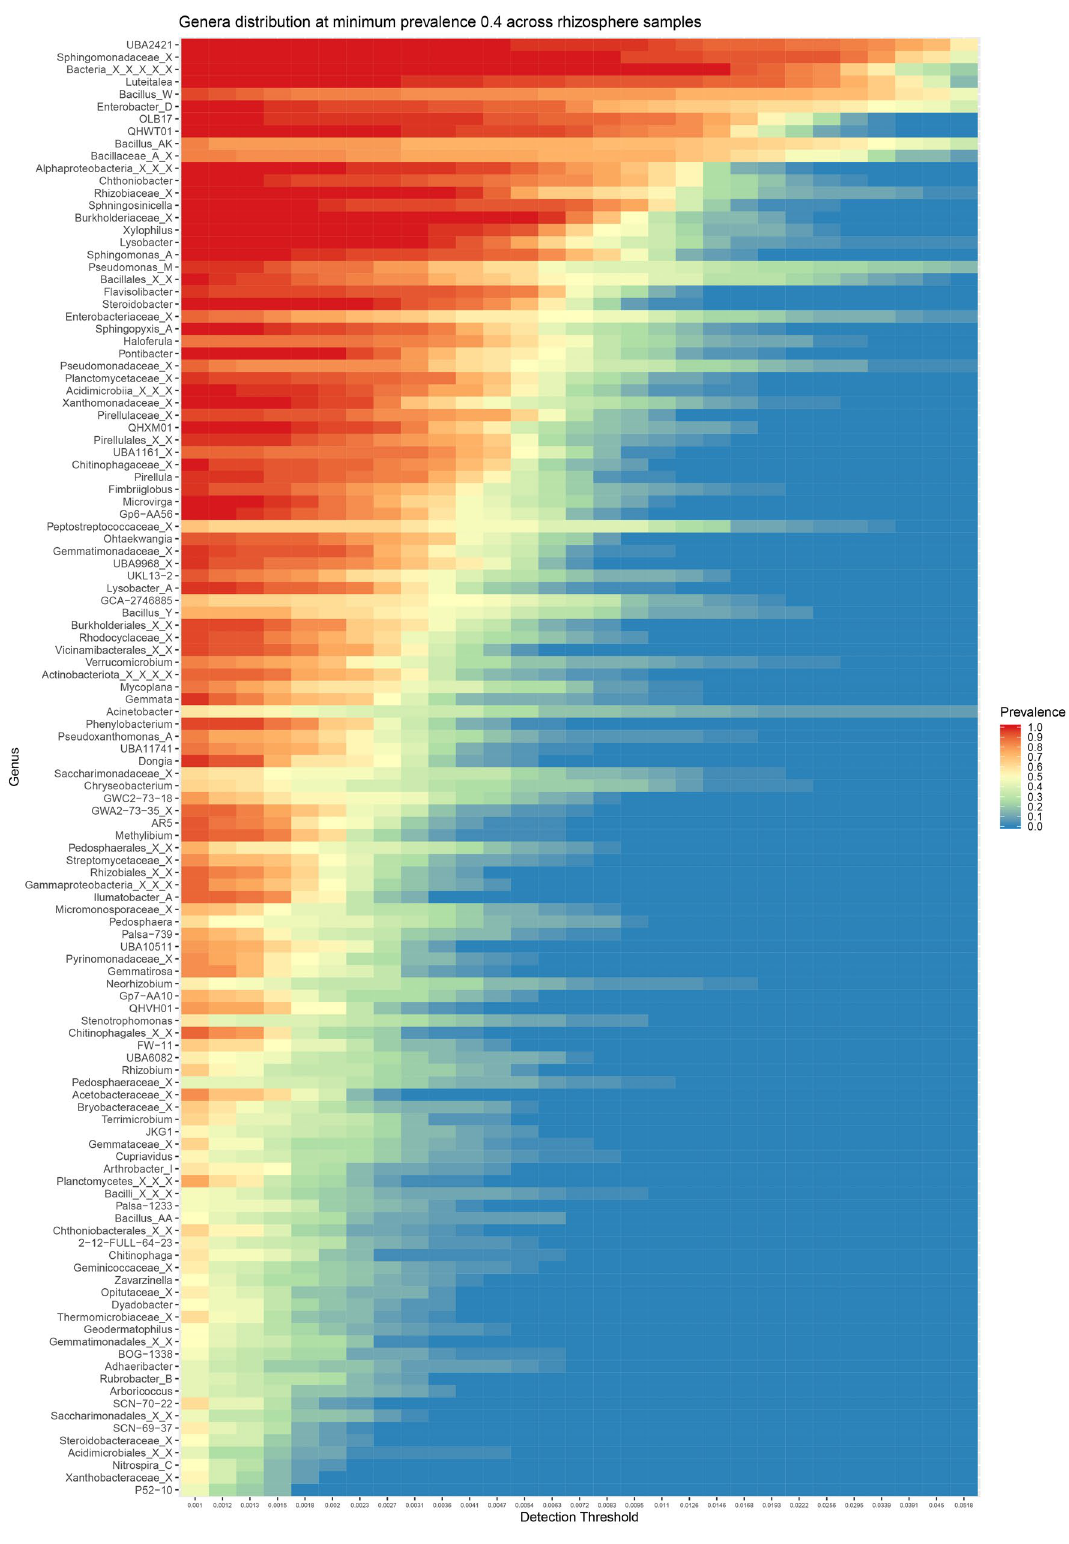
Figure 4. Plot representing core microbiome from rhizosphere samples. The plot compares prevalence of genus in samples across varying levels of abundance. Only the genera with minimum prevalence of 0.4 at 0.001 abundance are